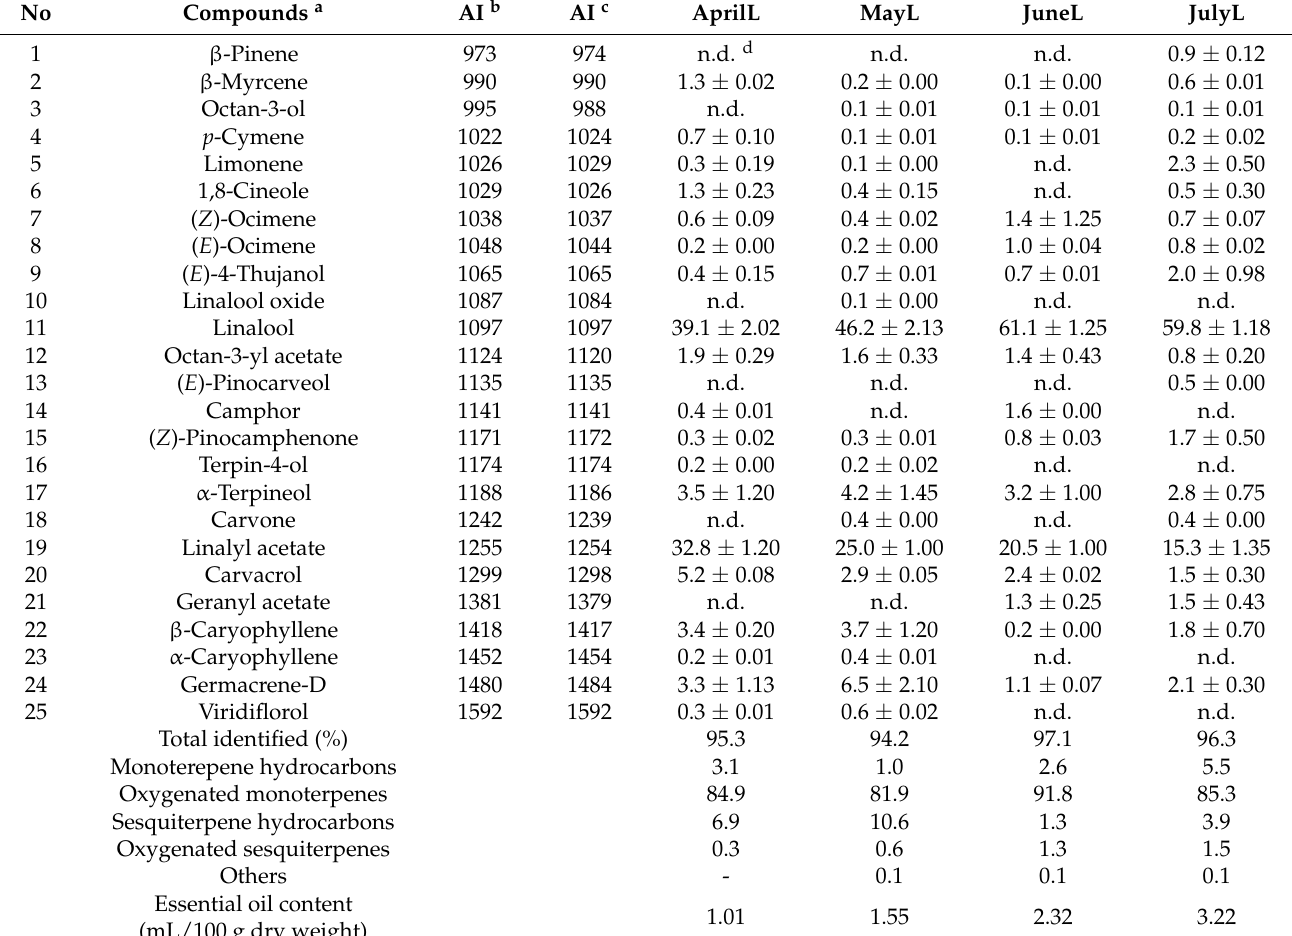
Table 1. Qualitative and quantitative composition of the Essential oils from M. × piperita